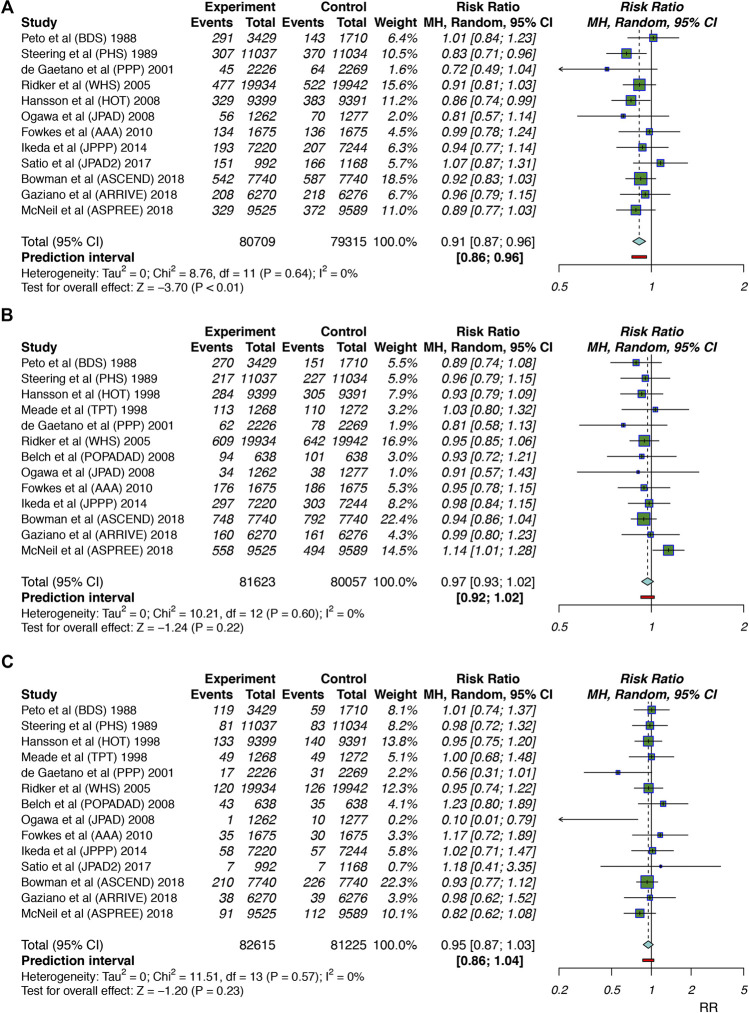
Summary forest plots for the primary efficacy outcomes. (A) Forest plot for CV events. (B) Forest plot for all-cause mortality. (C) Forest plot for cardiovascular mortality.